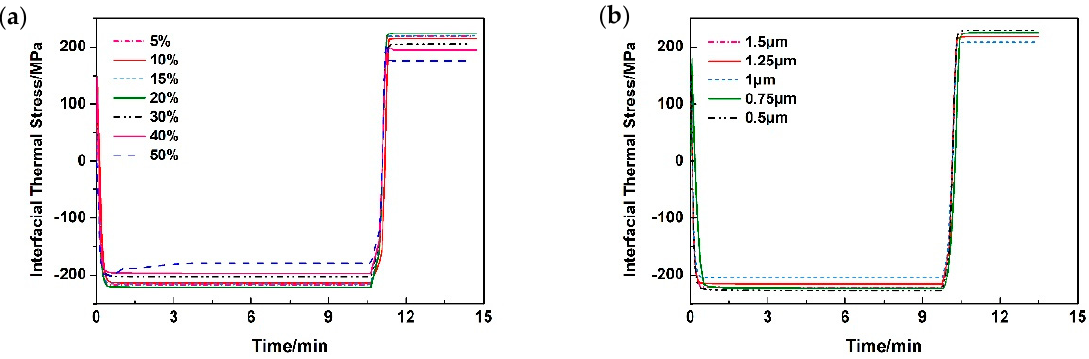
Figure 12. Curves of interfacial thermal stress versus time: ( a ) 1.5 μ m pore diameter, ( b ) 20% porosity.